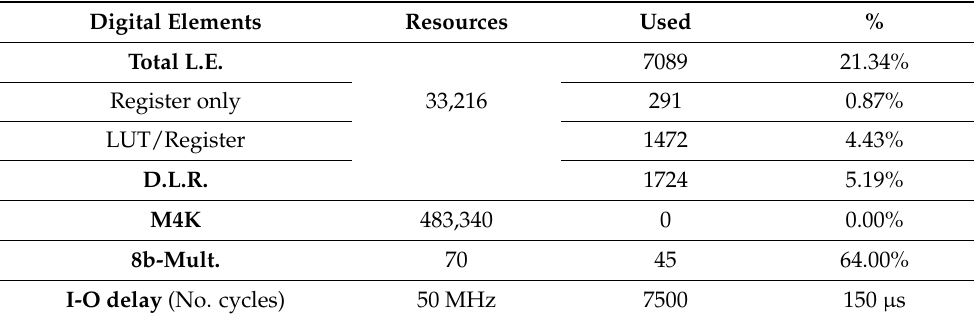
Table 5. Hardware resources used by the optimization